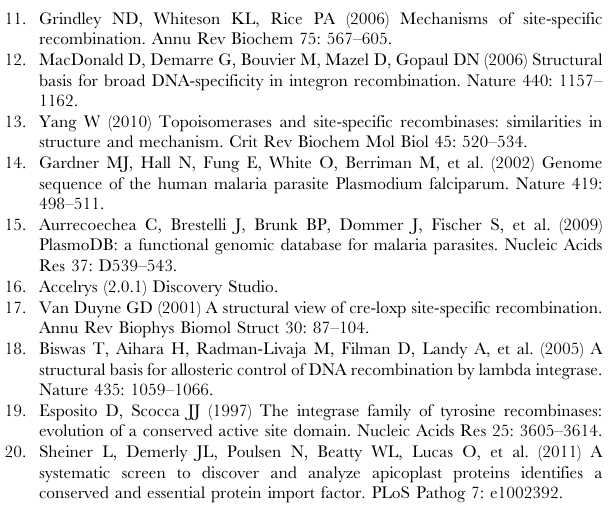
Figure S5 Analysis of DNA binding by Pf-Int. A ) The presence of 900 mM NaCl in the binding buffer of Pf-Int-C192/ Selex8 was also tested. B ) 10 nM of labeled fragment 1 gDNA target were allowed to bind with increasing amounts of Pf-Int- C162 (lanes 1 to 10). 10 nM of labeled fragment 1 gDNA target were incubated with 3 m M Pf-Int-C162 for 20 minutes (Lane 12) and then digested with the proteinase-K (Lane 13). Table S1 Oligonucleotides used for qRT-PCR, cloning and EMSA assays. The DNA primers used for cloning and qRT-PCR were single stranded, whereas the ones destined for EMSAs were annealed to their reverse complement to form the corresponding double stranded DNA. The EMSA DNAs, when specified, were uniquely 5 9 labeled with DY682 on the strands specified in this table. Table S2 Potential DNA targets identified for Pf-Int. A ) Targets identified by sequencing of eluted fragments retained by Pf-Int. B ) Targets identified by chip hybridization of eluted